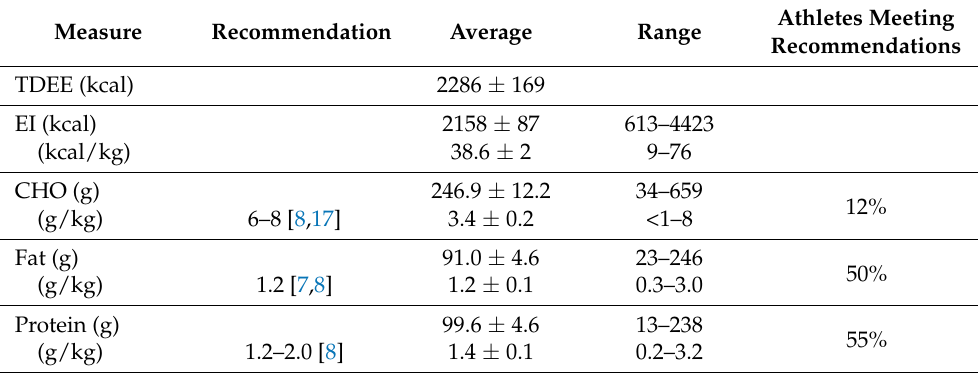
Table 3. Average weekly energy expenditure and energy and macronutrient intakes in comparison to recommendations for all